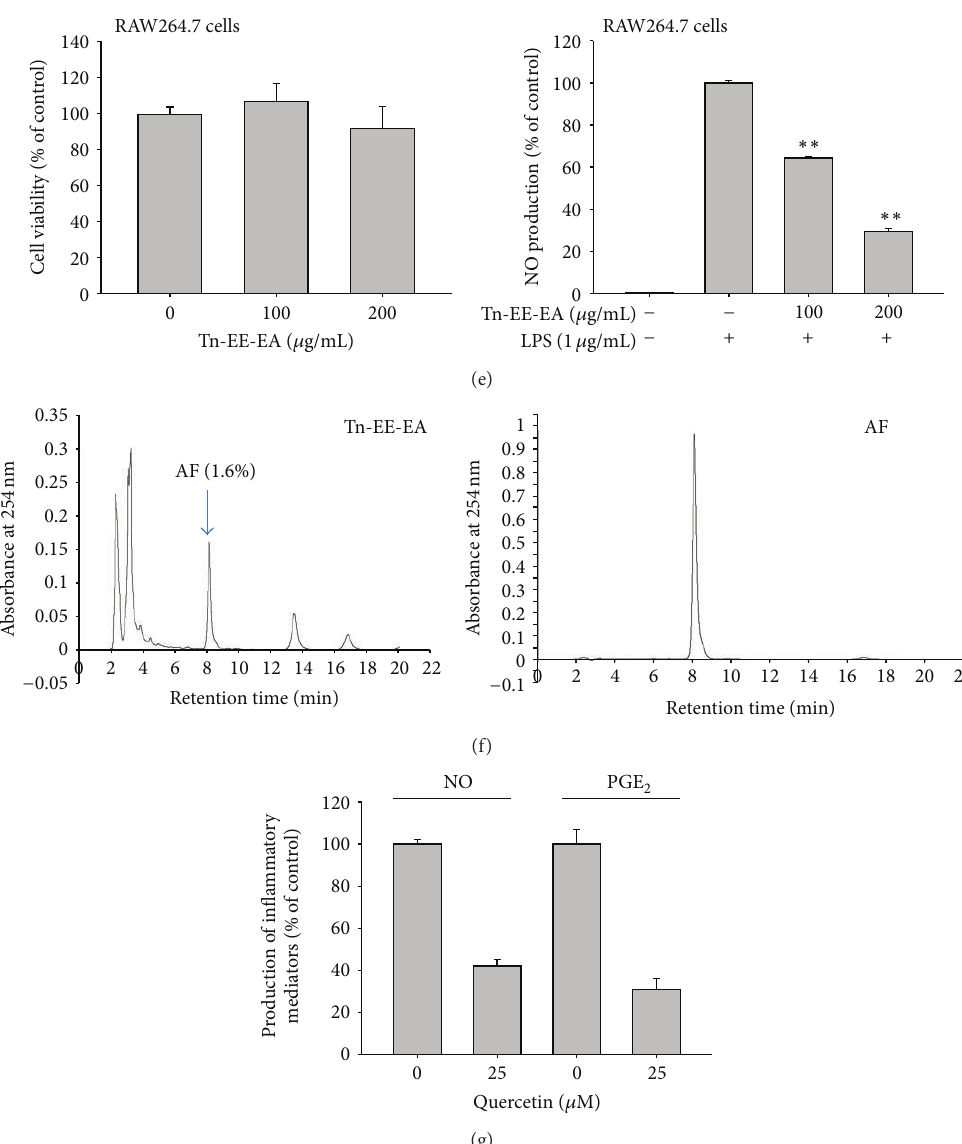
Figure 1: Effect of amentoflavone and Tn-EE-EA on the production of inflammatory mediators. (a) Chemical structure of amentoflavone (AF). (b, c, and g) Production of NO and PGE 2 in RAW264.7 cells treated with LPS (1 𝜇 g/mL) or pam3CSK (10 𝜇 g/mL) in the presence or absence of amentoflavone (from 0 to 200 𝜇 M) or quercetin (25 𝜇 M) was measured using the Griess assay and EIA. ((d) and (e), right panel) The viability of RAW264.7 cell treated with amentoflavone (from 0 to 400 𝜇 M) or Tn-EE-EA (0 to 200 𝜇 g/mL) in the presence or absence of LPS was determined using an MTT assay. (e) Production of NO in RAW264.7 cells treated with LPS (1 𝜇 g/mL) in the presence or absence of Tn-EE-EA (from 0 to 200 𝜇 g/mL) was measured using the Griess assay (left panel). (f) The content of amentoflavone from Tn-EE-EA was analysed using a high-performance liquid chromatograph (HPLC) (Knauer). ∗ 𝑃 < 0.05 and ∗∗ 𝑃 < 0.01 compared to the